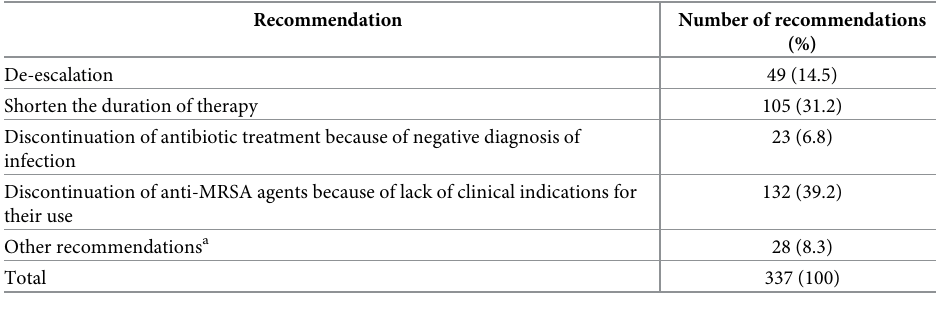
Table 2. Summary of recommendations by the